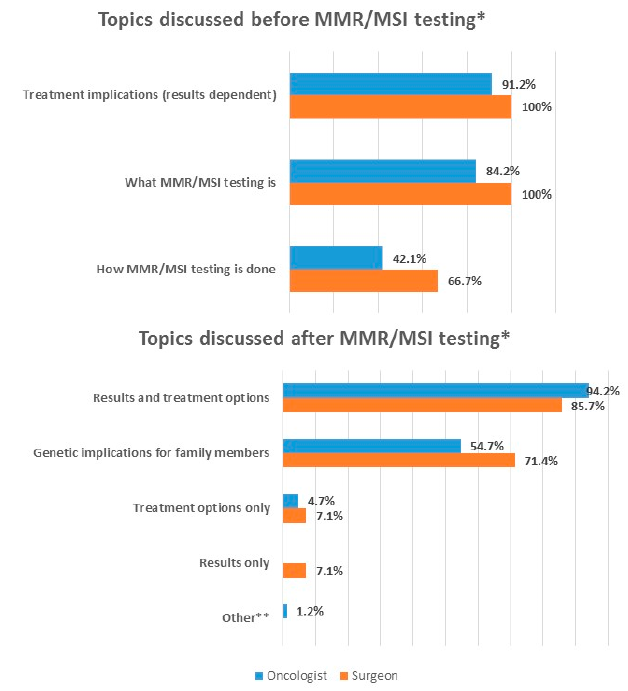
Figure 2. Physician discussion with patients—% of physicians agreeing with each statement. * Multiple selections were allowed. Thus, total percentage will not add up to 100%. ** Referral to genetic counselling.